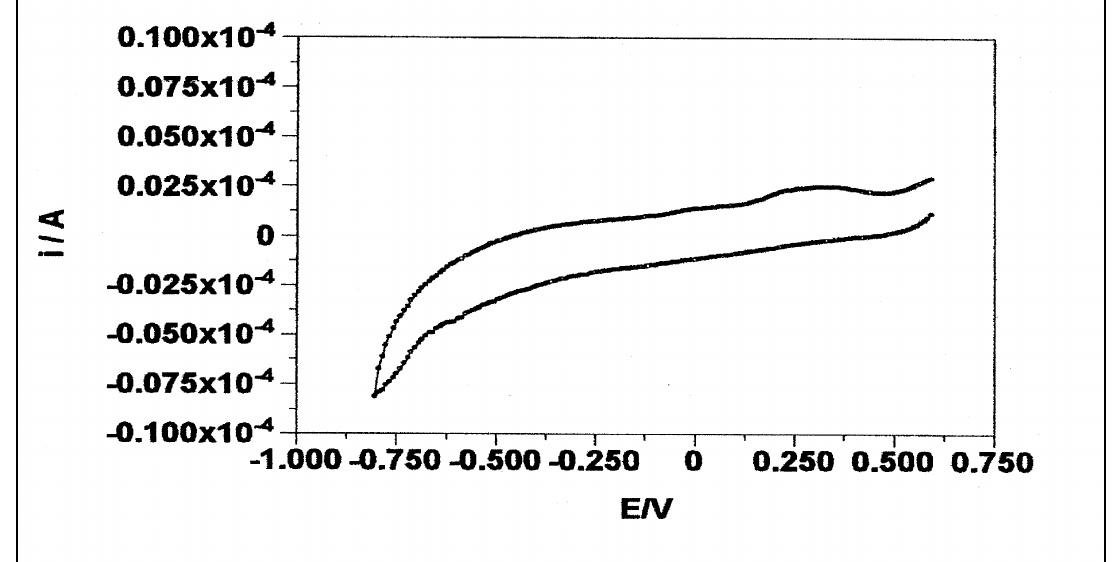
Figure B. Electrochemical behavior of the cysteamine